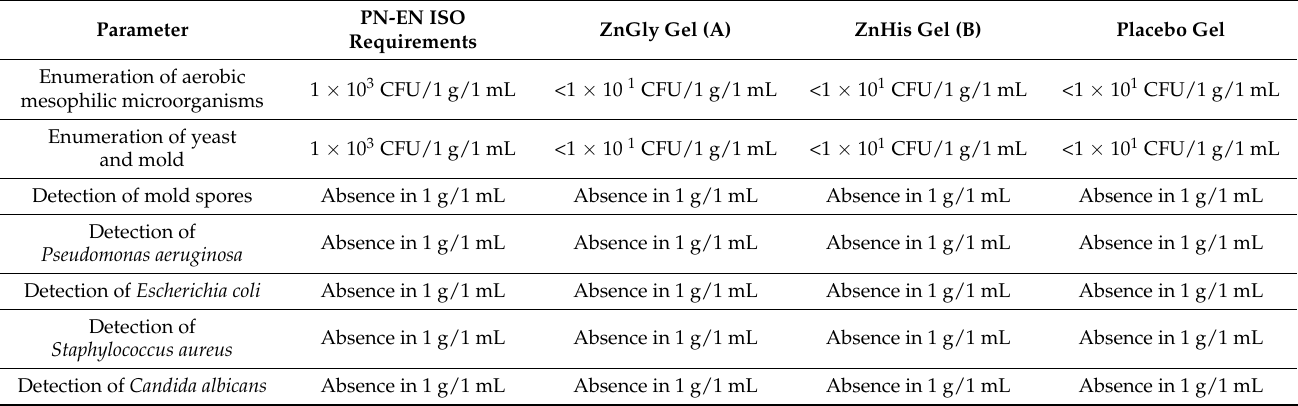
Table 4. Microbiological purity test of gel formulations.